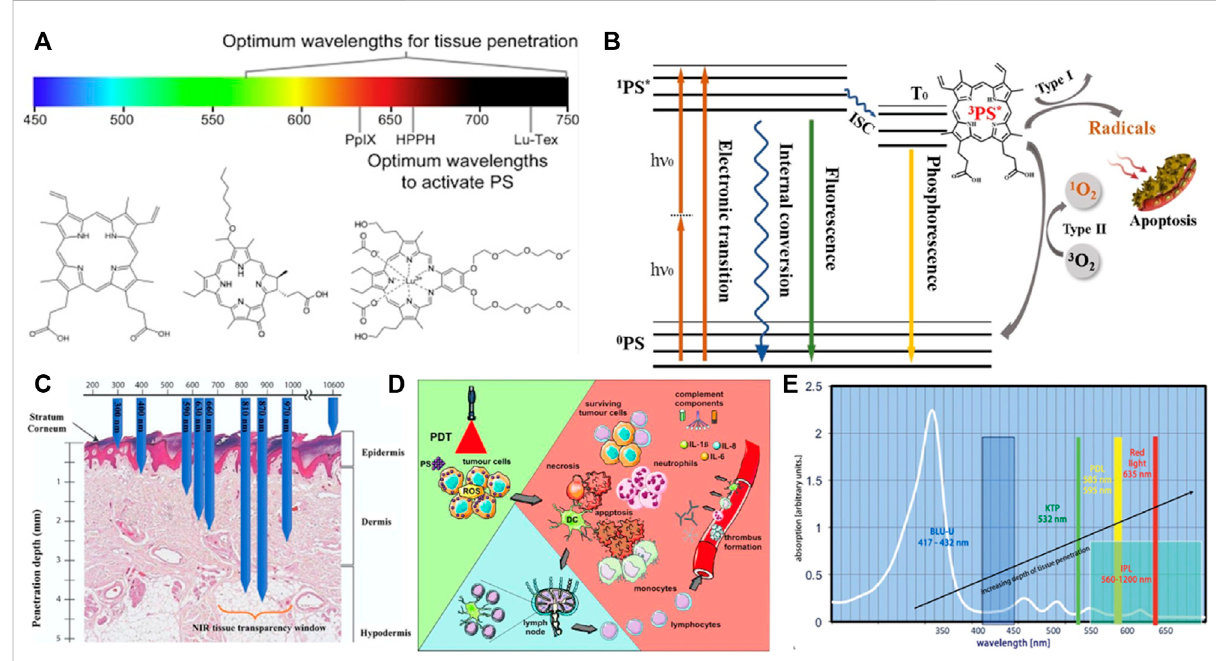
FIGURE 1 Fundamentals of Photodynamic therapy. (A) Visible and near infra-red light spectrum showing the wavelengths (nm) of maximum tissue penetration by light (above) and absorbance maxima of selected photosensitizers (below); Chemical structures of common photosensitizers including PpIX, HPPH, Lu-Tex from Dobson et al. (2018). (B) Jablonski level diagram and two approaches of photodynamic therapy. (C) Penetration depth of different wavelengths of laser in tissue, UV, ultraviolet light; VIS, visible light; NIR, near infrared light. (D) PDT-induced effects. (E) PpIX absorption in vivo for different kinds of light source from Ozog et al.